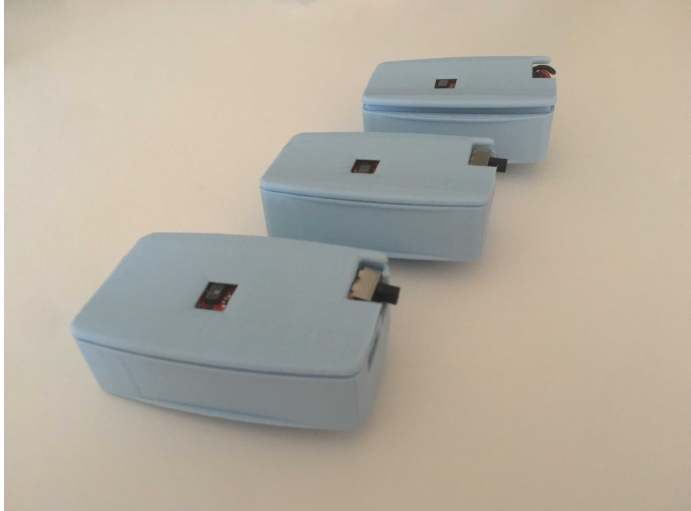
Figure 5. Photo of the developed specialized